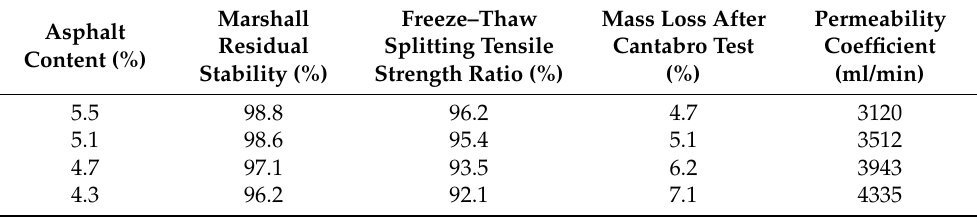
Table 3. EPA-13 road performance.